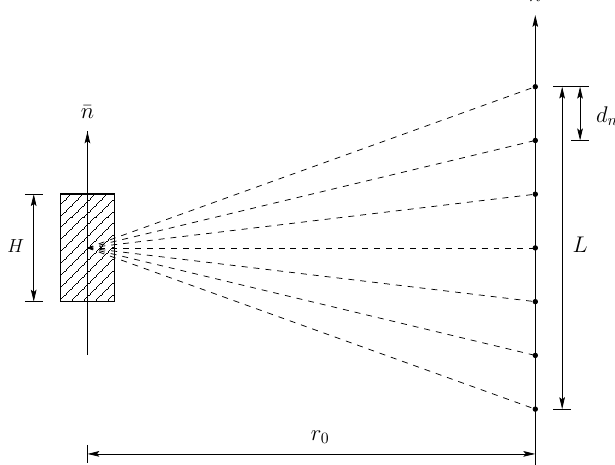
Figure 1. Simplified tomographic imaging geometry after [1]. A volume is illuminated from different positions along a synthetic aperture in normal direction n . Each position in normal direction corresponds to a sensor path in azimuth direction. The sensor paths are separated by a constant sampling spacing d . The maximal height of the volume is H . L is the length n of the synthetic aperture in normal